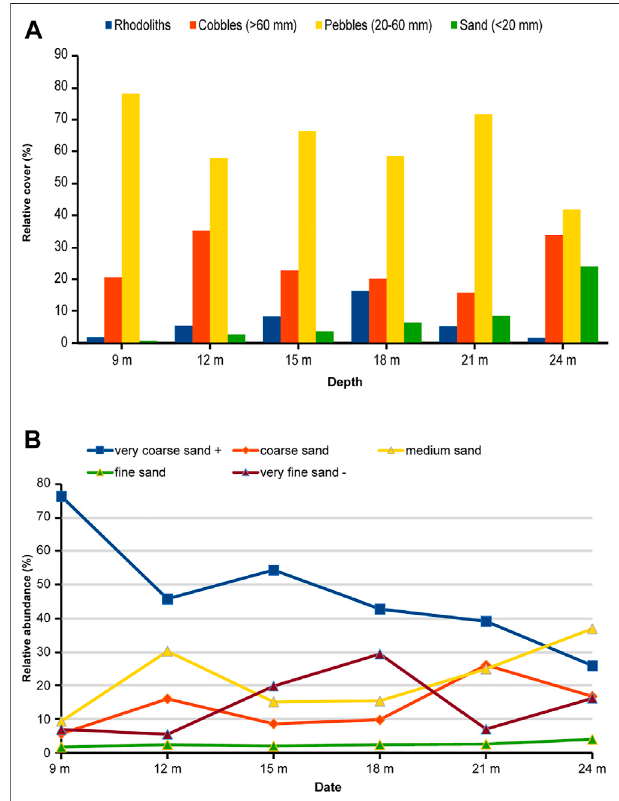
FIGURE5|(A) Proportionofrhodoliths and grain-sizeclasses(% cover) at different depths. (B) Proportion of sand-sized fractions ( < 2 mm) at different